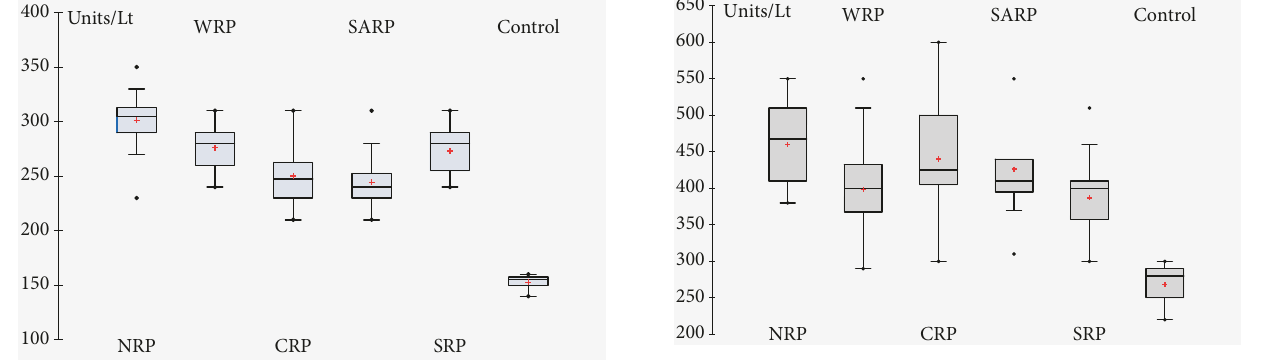
Figure 7: Serum glutamate-oxaloacetate transaminase (SGOT) activity.